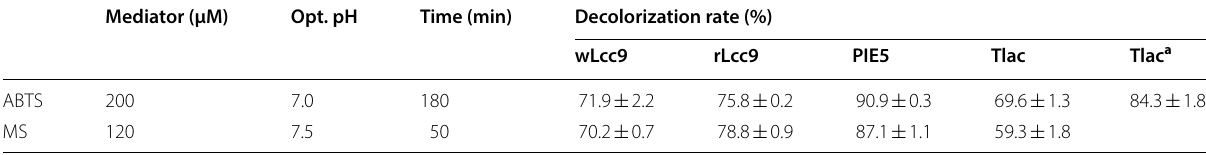
The data presented are the average values from triplicate parallel experiments and technical repeats of measurements (n a Reaction was conducted at pH 5.0 and 60 °C according to the manufacturer’s instruction, using 200 μM indigo and 200 U L − 1 enzyme for 3 h, without addition of any